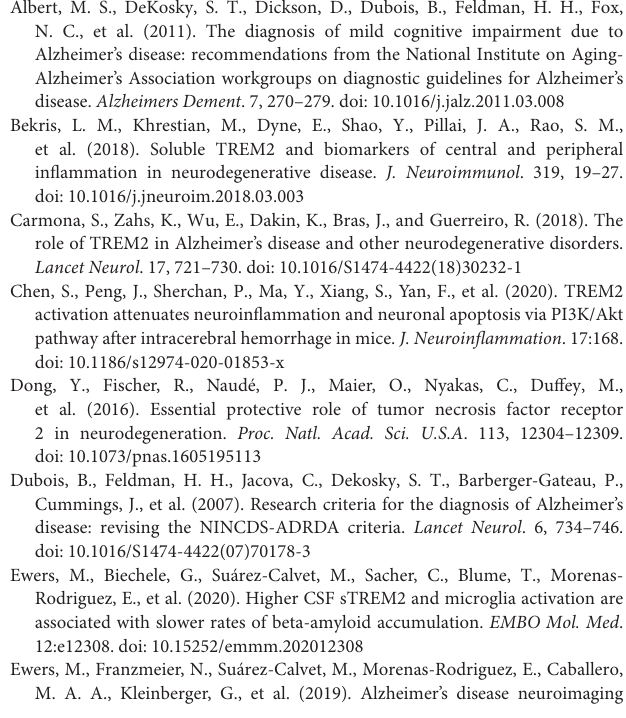
initiative. Increased soluble TREM2 in cerebrospinal fluid is associated with reduced cognitive and clinical decline in Alzheimer’s disease. Sci. Transl. Med